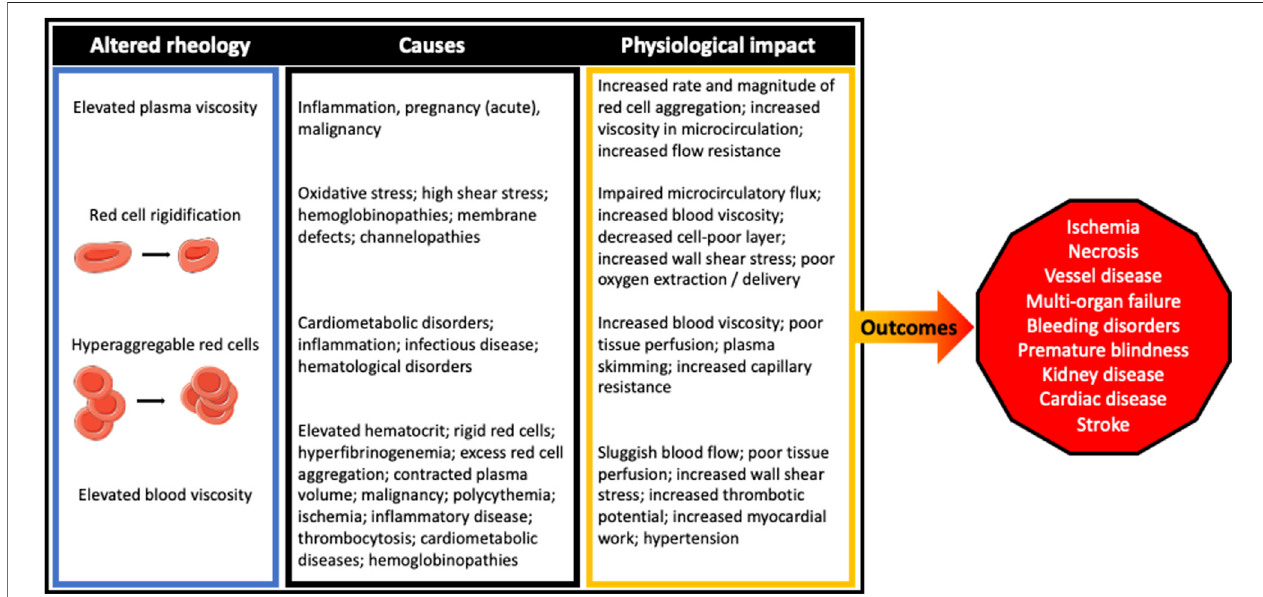
FIGURE 3 | The clinical outcomes for those suffering from rheological disturbances have seemingly diverse, although clearly interconnected pathogeneses. Irrespective of the cause, the impact of perturbed blood rheological properties tend to impair blood fl ow at both the macro- and microcirculatory scale.